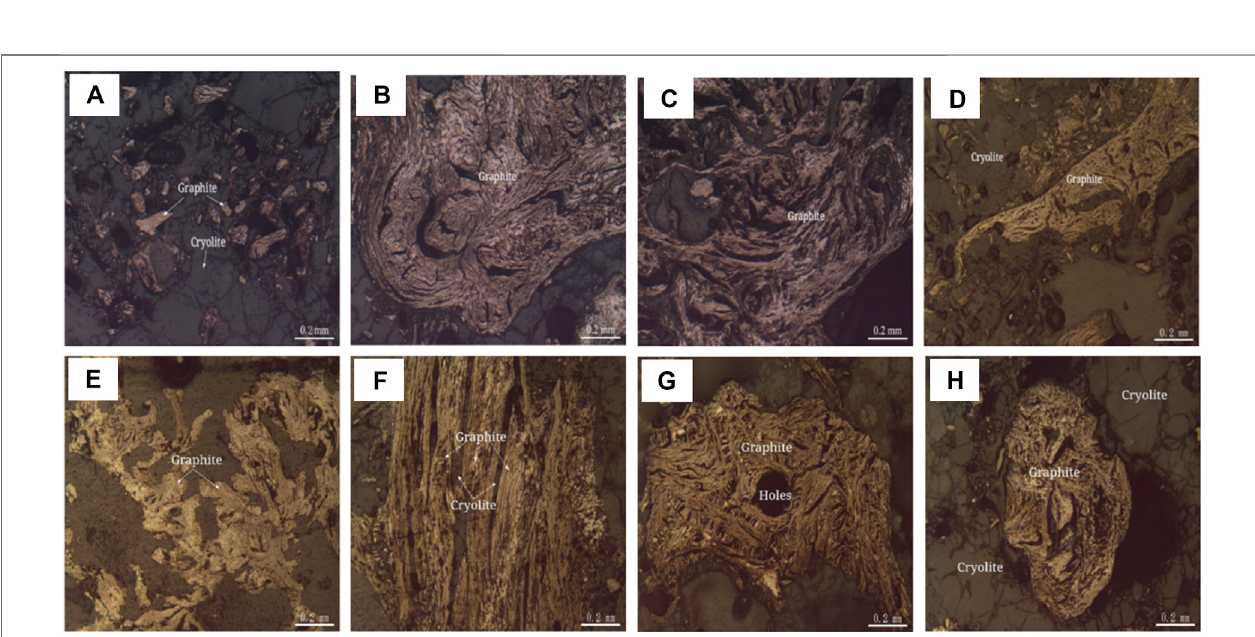
Frontiers in Materials |